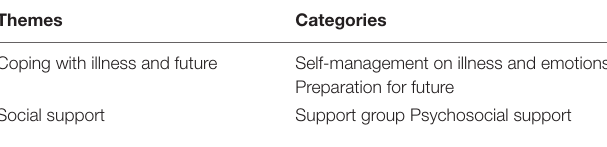
TABLE 3 | Findings on the elements to be included to the